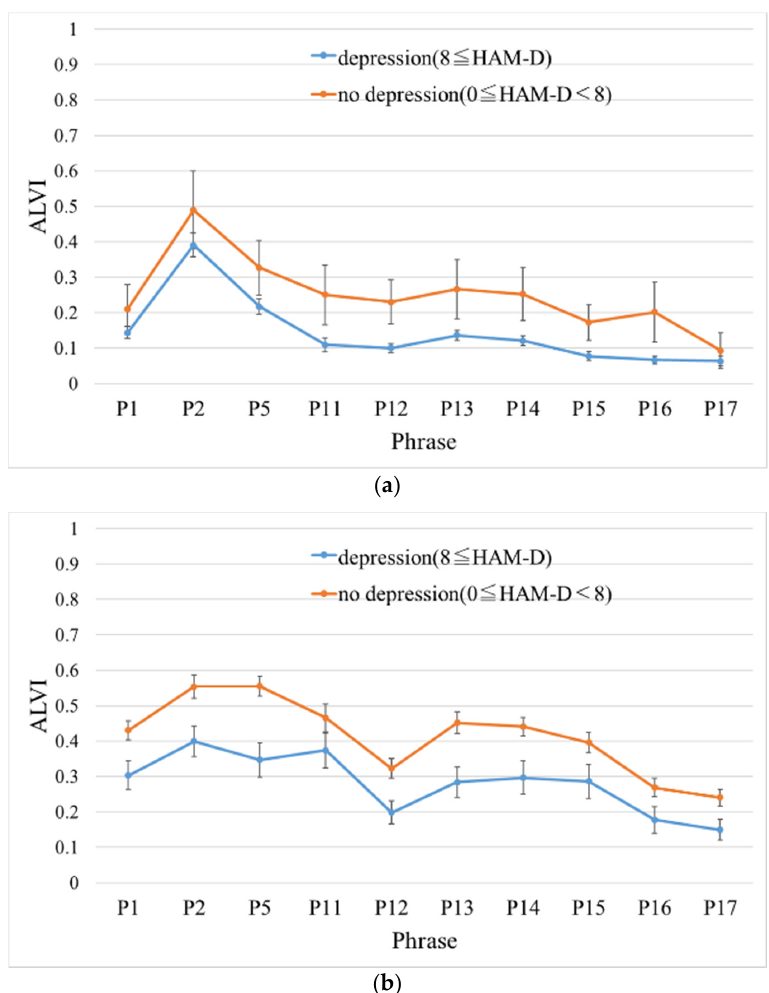
Figure 5. The mean of arousal level voice index of the no depression and depression groups for each phrase. ( a ) represents Ginza Taimei Clinic (H1) and ( b ) represents National Defense Medical College (H2). Error bars represent standard error. (Note. ALVI: arousal level voice index; HAM-D: Hamilton Rating Scale for Depression). Table 4. A summary of classification performance between the no depression and depression groups Table 4 highlights the classification performance between the no depression and depression groups through ALVI. The table shows the results of comparing the mean ALVI of each group using the Wilcoxon rank-sum test and the AUC for each phrase. At H1, the discrimination performance for phrase 12 was the highest, and the AUC was 0.70 (cutoff point = 0.14, sensitivity = 0.70, specificity = 0.73). In contrast, at H2, the discrimination performance for phrase 5 was the highest, and the AUC